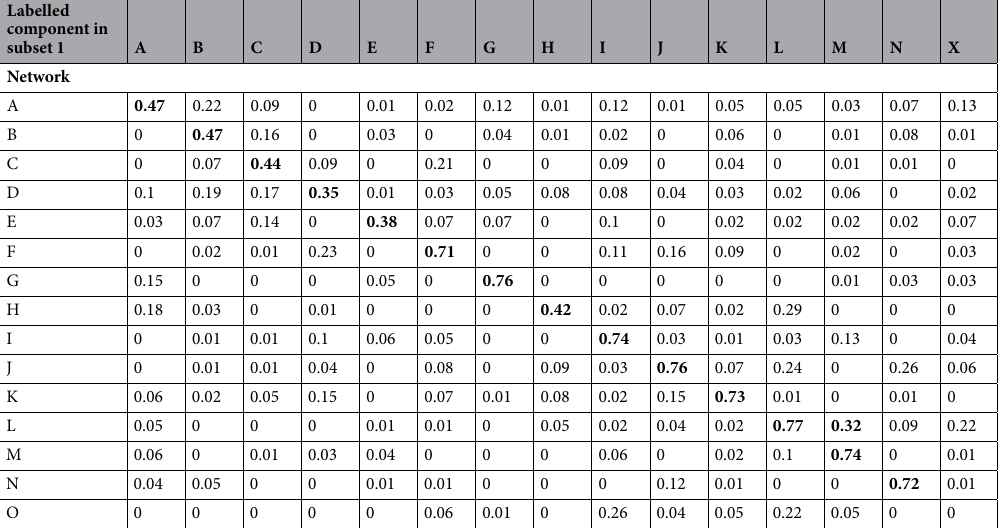
Table 2. Dice similarity coefficients used for labelling the components of subset 1. Dice similarity coefficients over 0.3 are highlighted in